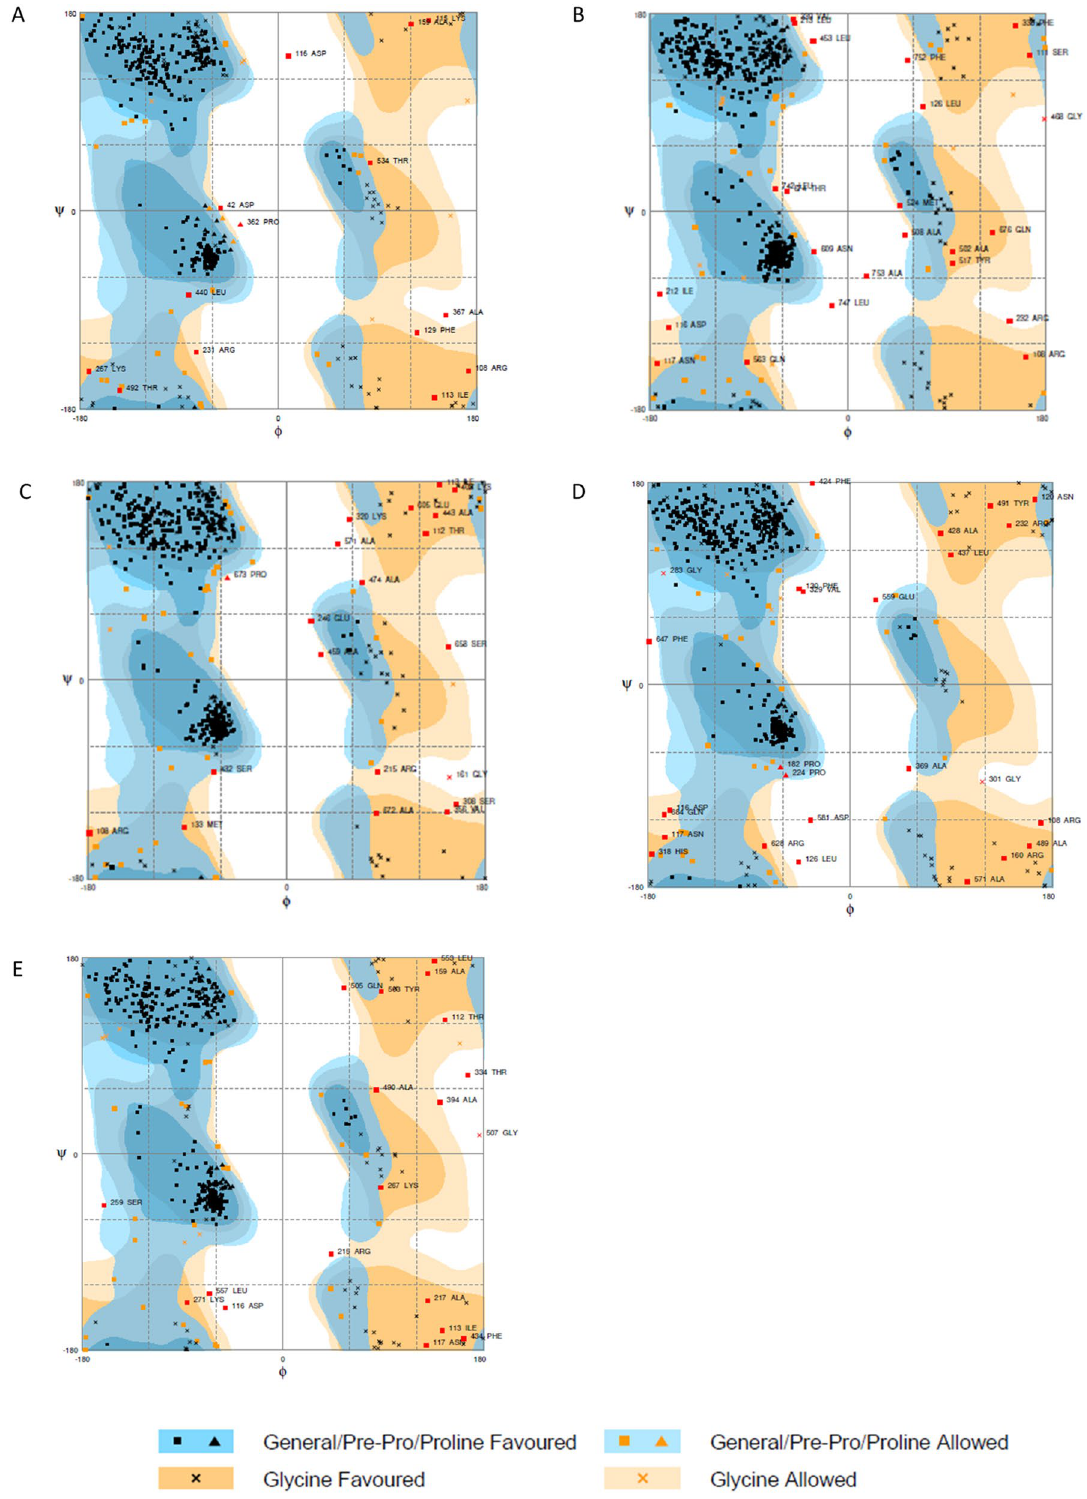
Figure 5. Ramachandran plots of the ZIKVac alone ( A ) and linked with the adjuvants, which are the flagellin ( B ), 50S Ribosomal protein ( C ), Heparin-binding hemagglutinin (HBH) ( D ) and RS09 ( E ). Black squares and triangles in blue areas indicate General/Pre-Pro/Proline Favored, orange squares and triangles in lighter blue areas indicate General/Pre-Pro/Proline Allowed, black Xs in orange regions indicate Glycine Favored and Orange Xs in lighter orange regions indicate Glycine